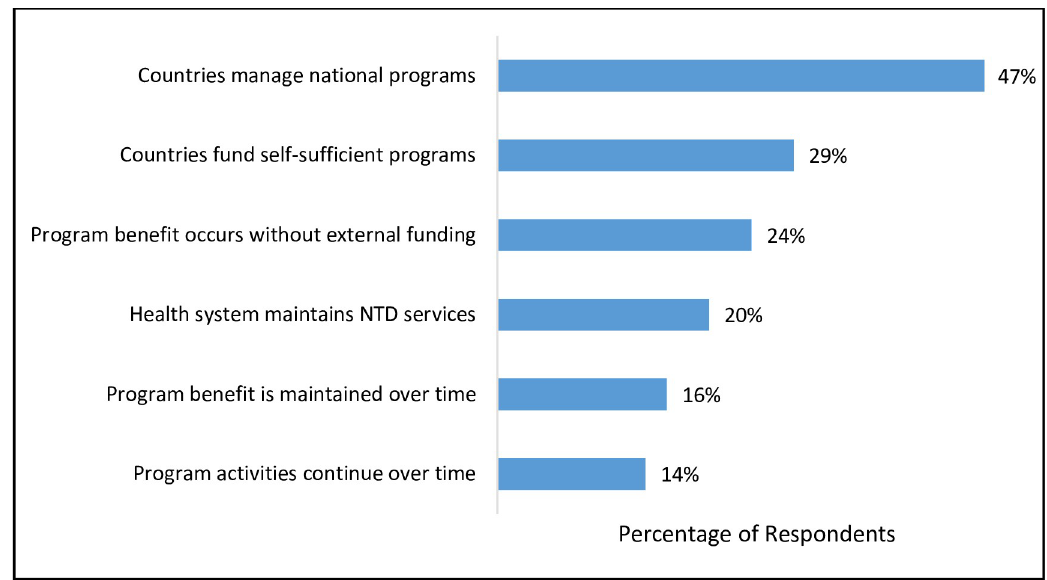
Fig 1. Elements Mentioned in Definitions of